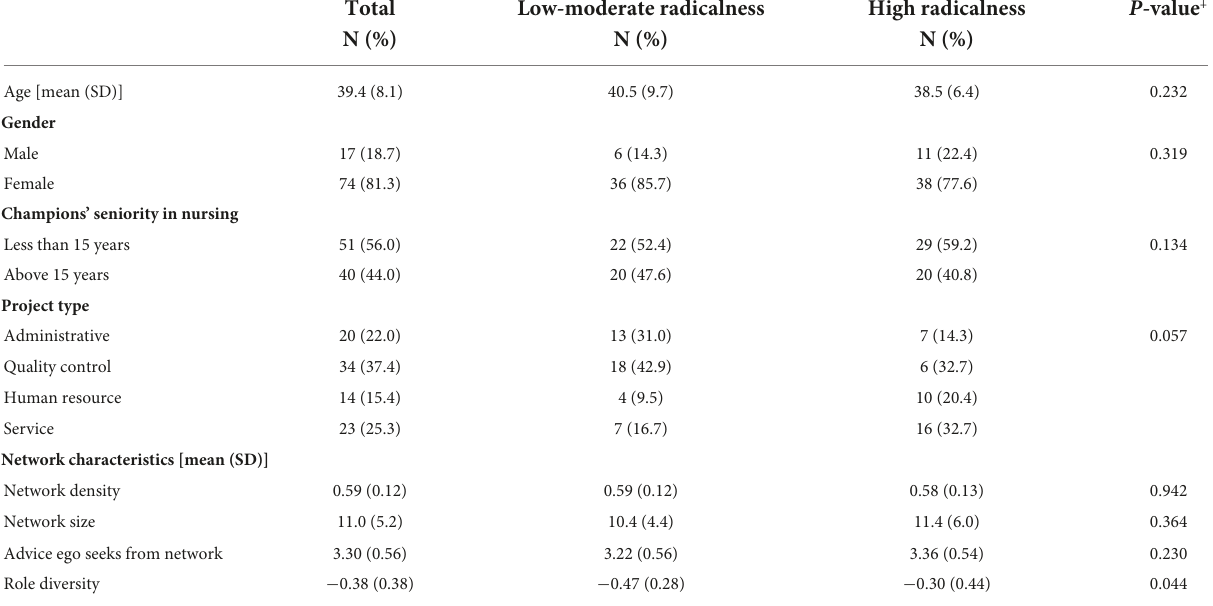
TABLE 2 Sample characteristics.